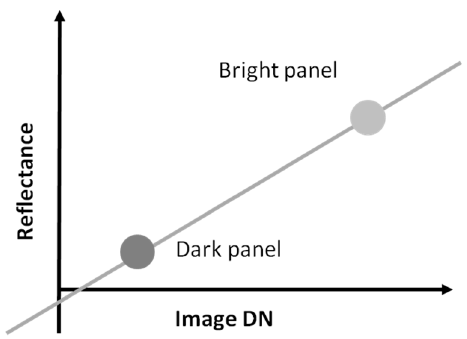
Figure 5. Illustrating how the equation for the empirical line method is derived from one dark and one bright reflectance calibration panel to get the slope ( a in Equation (3)) and the intercept ( b in Equation (3)) of the empirical line. In this study, two or three panels were used to derive the equa- tion.